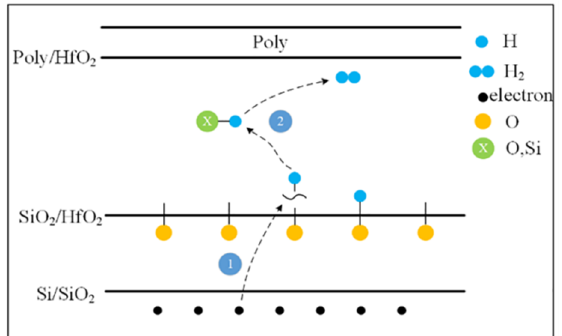
Figure 7. Mechanism of interface trap generation in a high ‐ K dielectric.